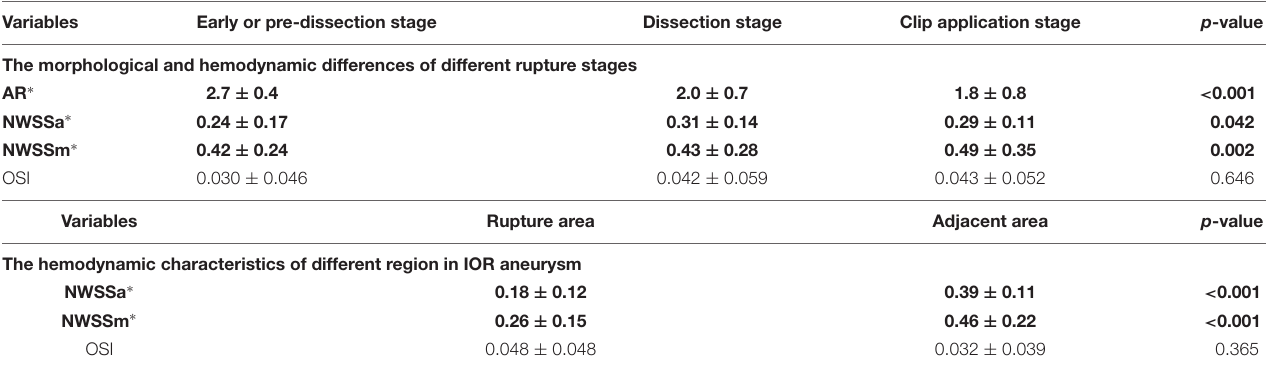
TABLE 4 | The morphological and hemodynamic differences of different rupture stages, and the hemodynamic characteristics of different region in IOR